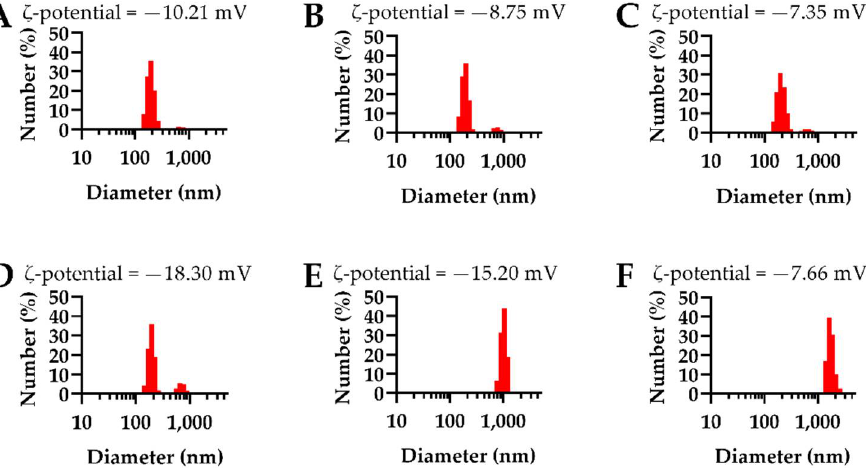
Figure 3. DLS and ζ -potentials reveal NEMO particle stability and NEIO particle aggregation with increasing PEGylation. Hydrodynamic size distributions and corresponding ζ -potentials are shown for ( A – C ) NEMO and ( D – F ) NEIO particles synthesized with increasing amounts of PLGA-PEG including ( A , D ) 0%, ( B , E ) 2.5%, and ( C , F ) 5% w / w . ( A – C ) NEMO particles had consistent distributions across all samples with ~94% or greater of NPs within the first, smaller-sized population leaving ~6% or less of NPs within the larger-sized population. ( D ) The size distribution of 0% PLGA-PEG NEIO particles was similar to their NEMO particle counterparts; however, ~16% of NPs lie within the larger-sized population, which is double compared to the NEMO particles. ( E , F ) For both 2.5% and 5% PLGA-PEG NEIO particles, the size distributions were monodispersed at greater than 1 µ m. It should be noted that with increasing PEGylation, ζ -potential became more neutral for both NEMO and NEIO particle formulations.